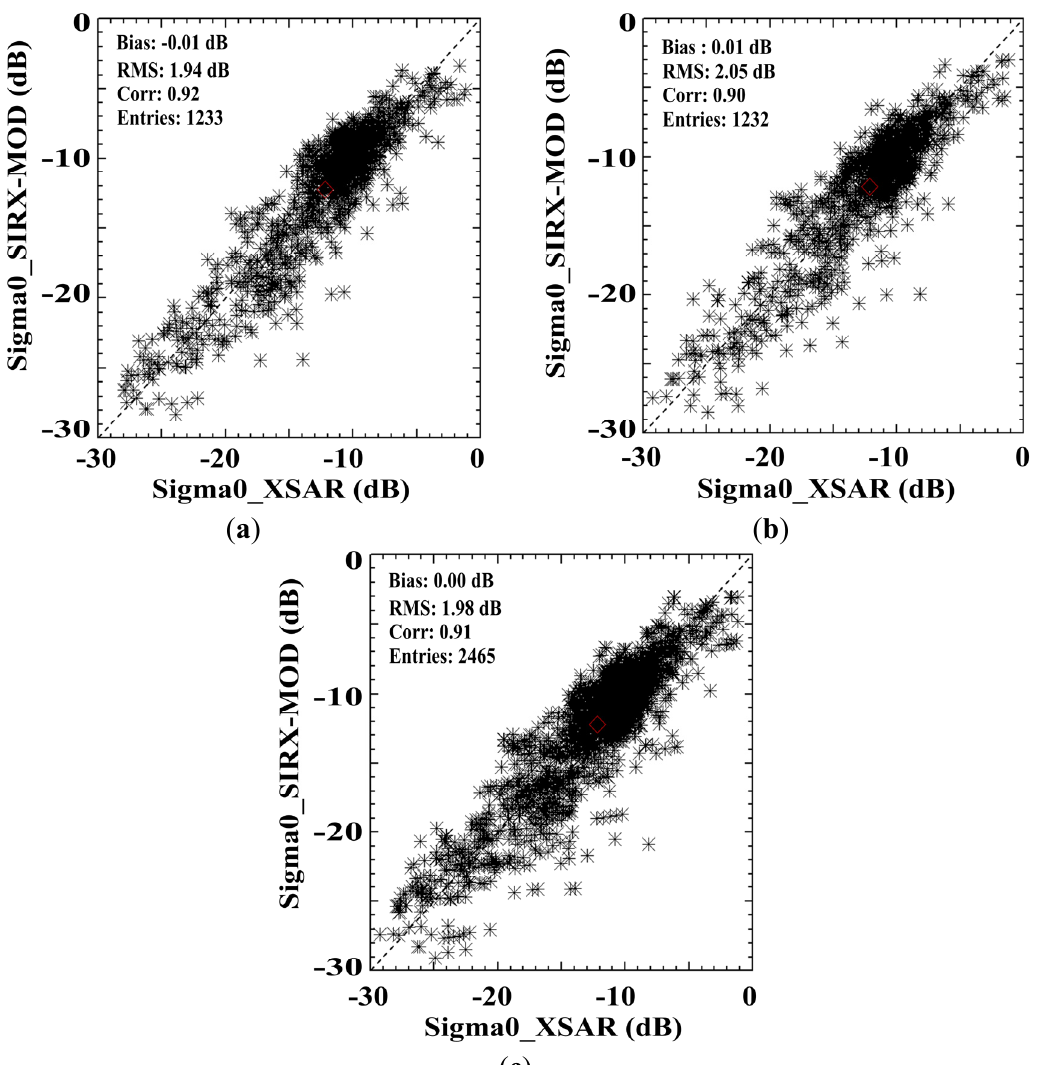
Figure 6. Comparison between the NRCS simulated by the SIRX-MOD model and X-SAR observations for ( a ) dataset 1; ( b ) dataset 2 and ( c ) all